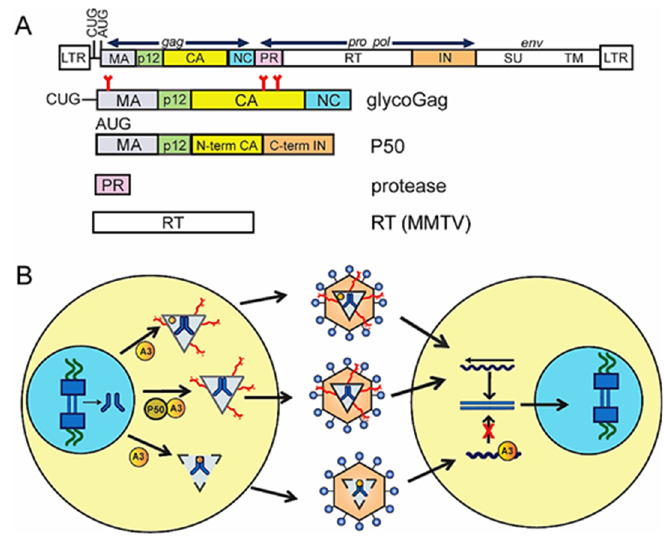
Figure 2. Mouse mammary tumor virus (MMTV) and murine leukemia virus (MLV) proteins that counteract APOBEC3. ( A ) Diagram of MLV genome and identified viral anti-APOBEC3 proteins. GlycoGag translation initiation from a CUG upstream from the Gag translation start site. Red lines